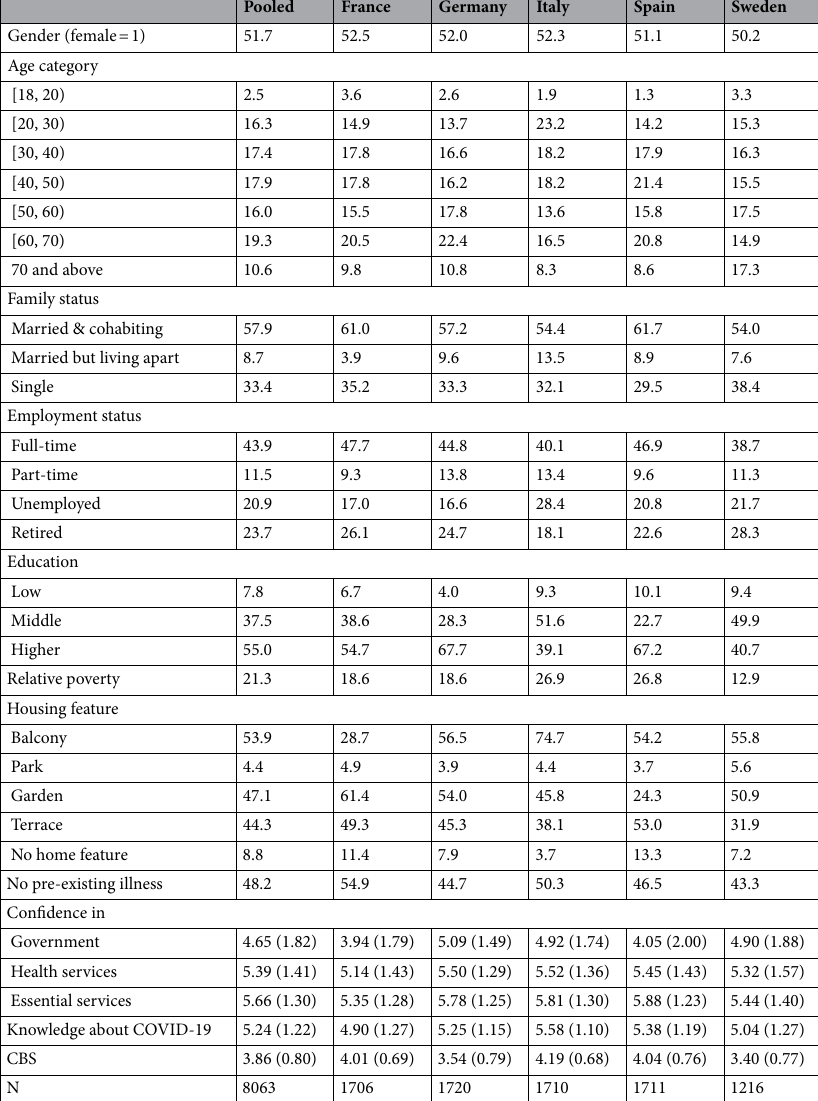
Table 1. Descriptive statistics of selected variables. This table presents summary statistics of respondents’ key characteristics and target variable in each sample used in the final prediction. The first column shows the summary statistics of selected variables of the pooled sample. The other columns list summary statistics of selected variables in each country. The numbers in the tables show the percentages. The figures followed by parenthesis are the mean and standard deviation of the variables, respectively. For the sake of presentation, the eight levels of education are recoded into three-level ISCED aggregation. CBS denotes the coronavirus behavioral